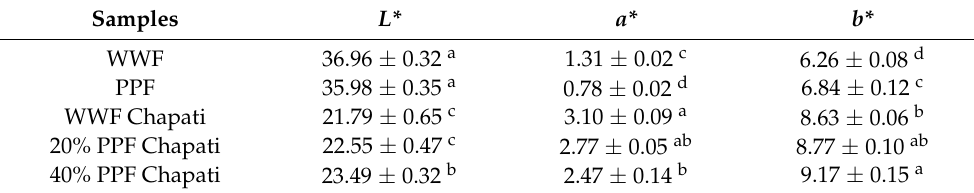
Table 2. Color profiles of pigeon pea flour (PPF), whole wheat flour (WWF), and the chapatis. Samples